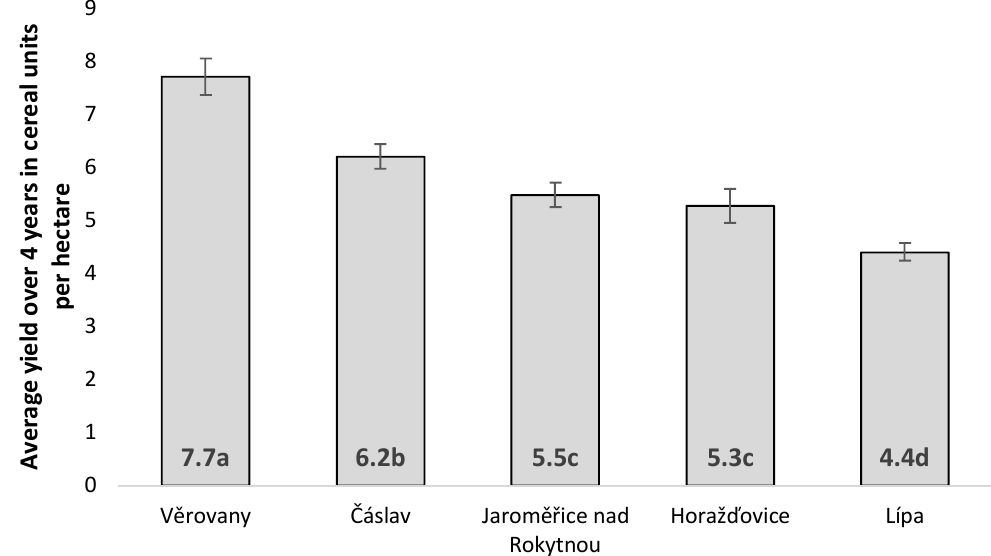
Figure 10. Average crop yield over four experimental years recalculated to the cereal units per hectare (observed experimental localities). Error bars represent the standard error (SE). Different letters mean statistical difference ( p ≤ 0.5).